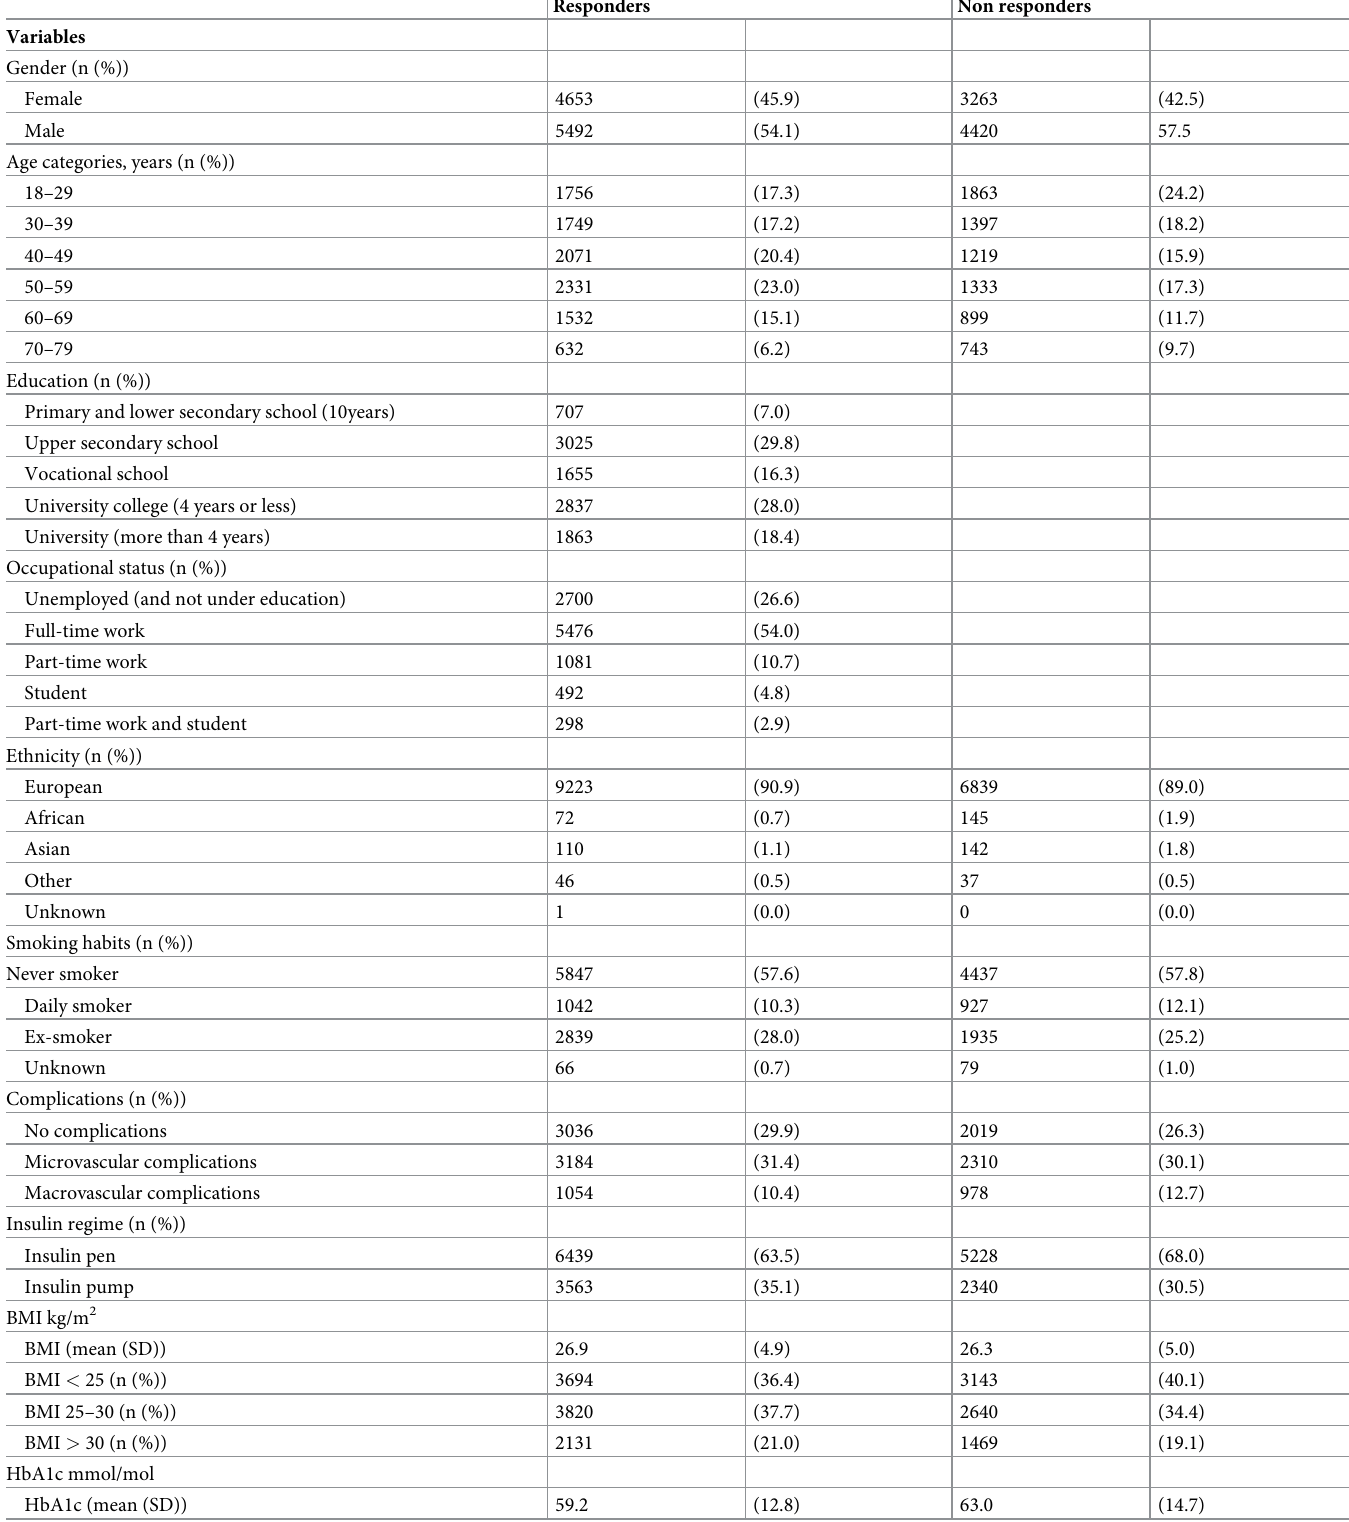
Table 1. Demographic and clinical data for the study population that completed the fear of covid 19 questionnaire (responders, n = 10145), compared with patients that did not answer the form, or had incomplete answers (non-responders, n =